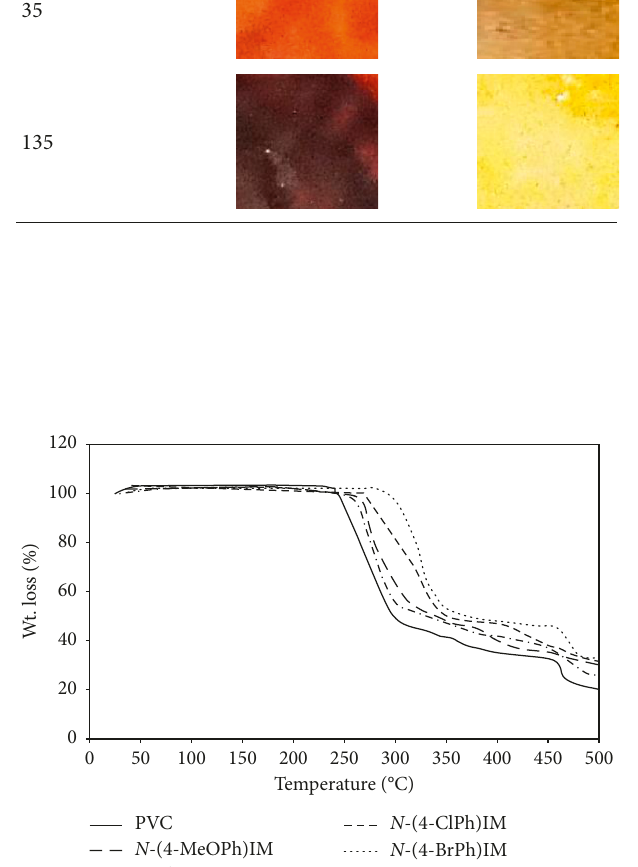
Figure 6: Effect of monomer concentration on the degree of grafting on PVC by N -PhIM. Initiator concentration of 1.5mol/L × 10 − 2 at 60 ° C for 17h.